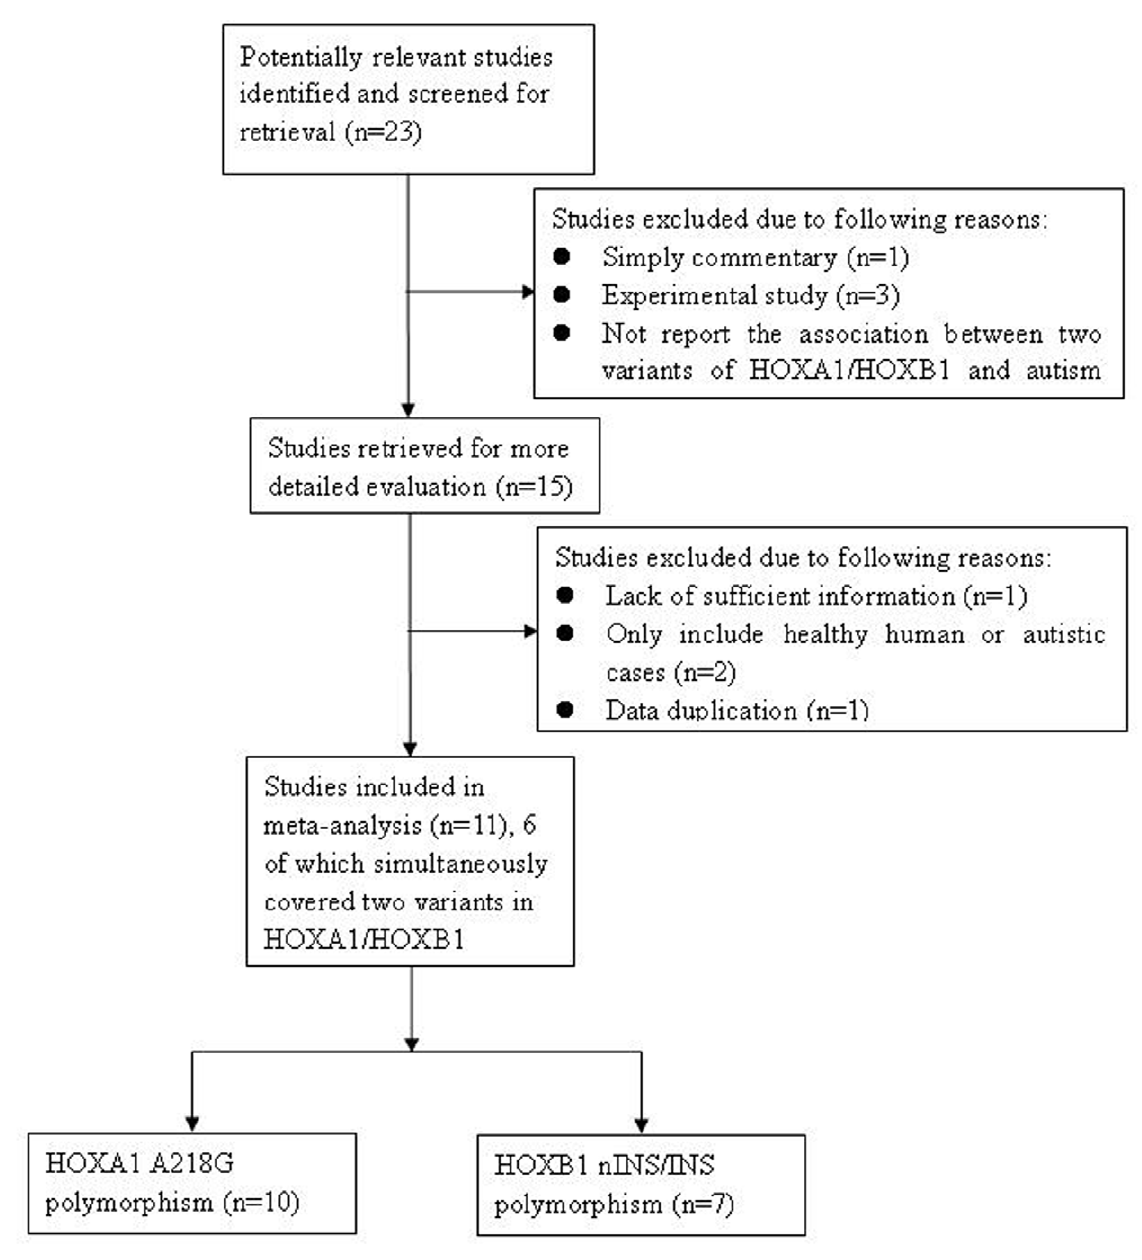
Figure 1. Flow diagram of the study selection procedure.